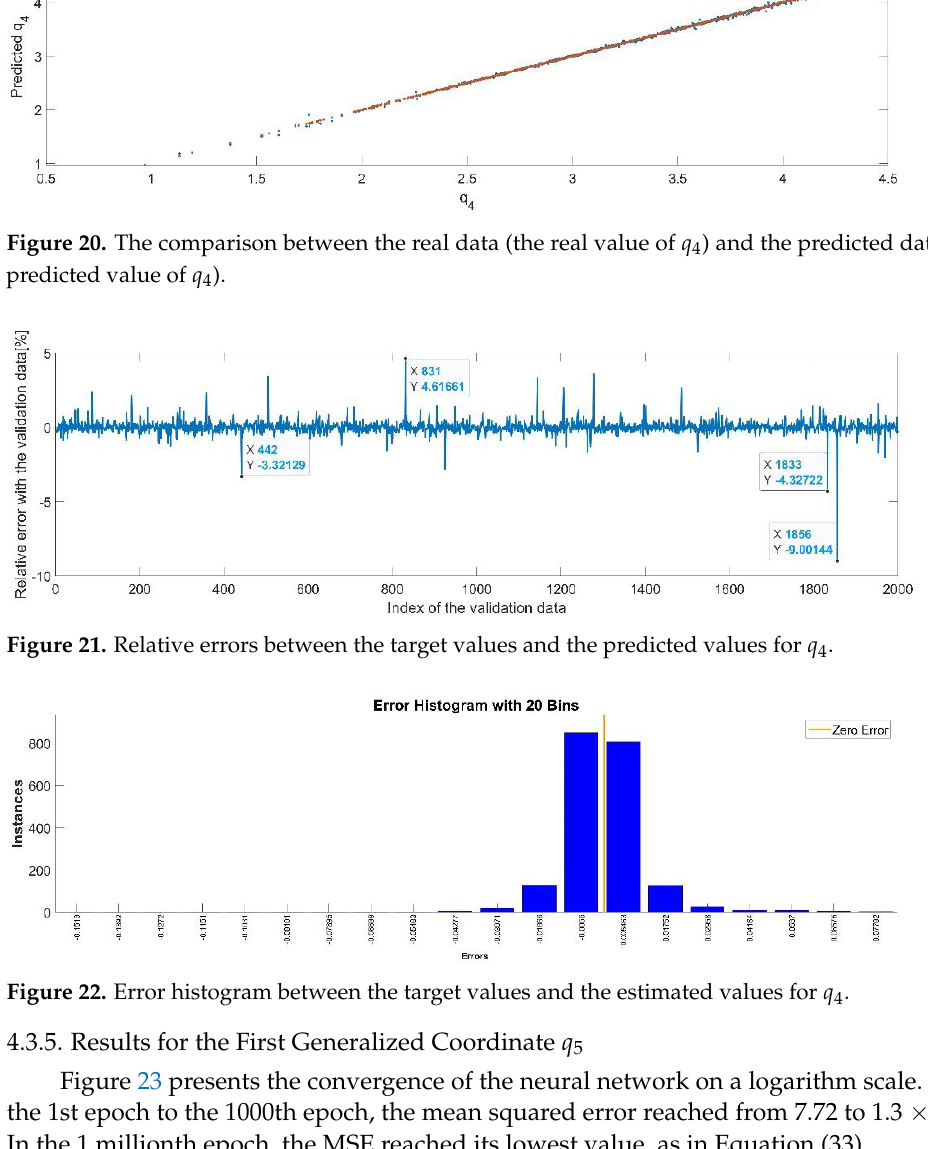
Figure 20. The comparison between the real data (the real value of 𝑞 4 ) and the predicted data (the